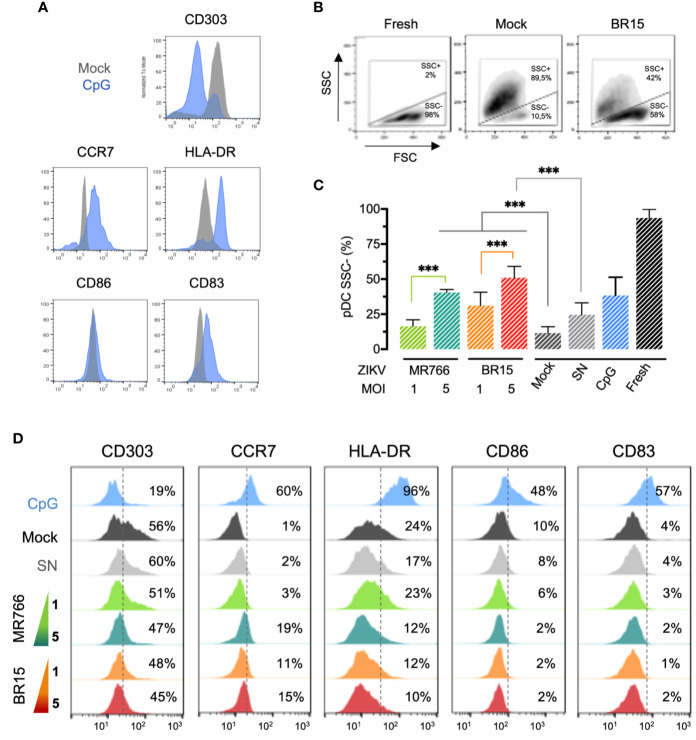
Impact of ZIKV on pDC maturation (A) Phenotypic characterization of mature pDCs. Sorted pDCs were either incubated with medium (Mock) or stimulated with ODN 2006 for 24 h and the expression of the indicated markers was analyzed. (B) Repartition of pDCs within two sub-populations according to FSC/SSC parameters. Shown are representative density plots of pDCs freshly isolated, incubated with medium, or exposed to ZIKV BR15 at MOI of 5. (C) Proportion of freshly isolated pDCs or pDCs cultured for 24 h clustered within the SSClow populations. Cultured cells were either incubated with medium (mock), stimulated with ODN 2006, or exposed to different MOI of indicated ZIKV strain or to virus-free supernatant (SN). The error bars represent the standard deviations of at least three experiments conducted with primary cells from distinct donors, except for ZIKVs MOI of 5 (two donors in duplicate). (D) Phenotypic characterization of pDCs cultured for 24 h. pDCs were either incubated with medium (mock), stimulated with ODN 2216, or exposed to different MOI of indicated ZIKV strain or to virus-free supernatant (SN), and the expression of the indicated maturation markers was analyzed. The dotted line represents the positive expression limit of the specified marker and the percentage of cells expressing it is indicated. Results shown in panels (A, B, D) are representative of at least three experiments conducted with primary cells from distinct donors, except for ZIKVs MOI of 5 (two donors in duplicate). ***p < 0.0001.